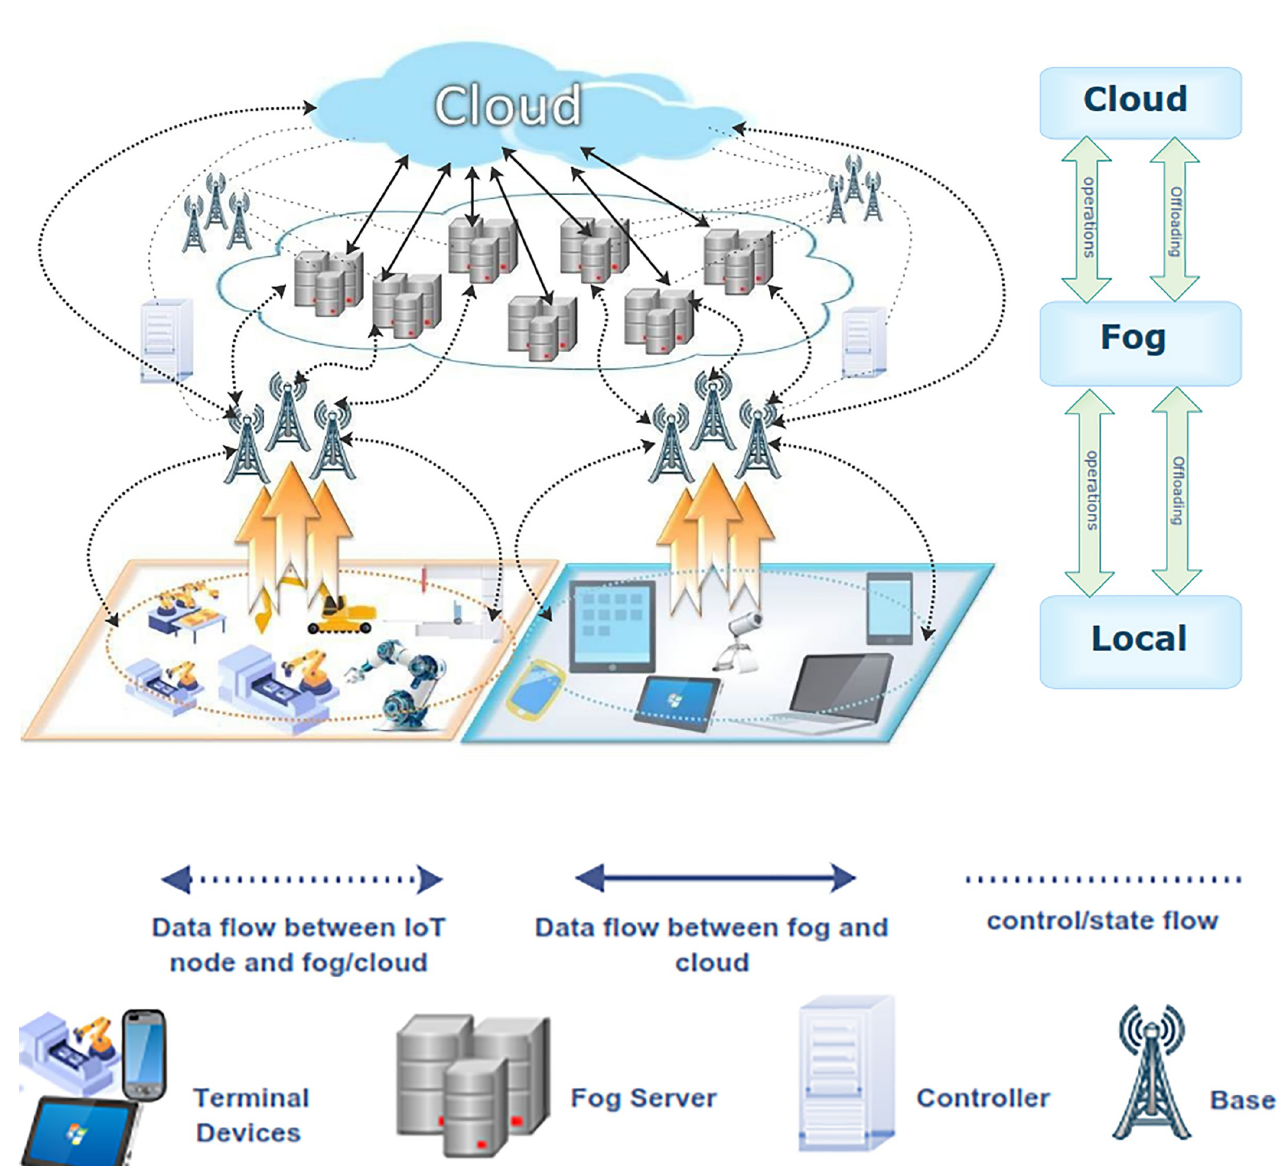
constraint T max (in second) to satisfy QoS. The Industry 4.0 service is based on N computing s